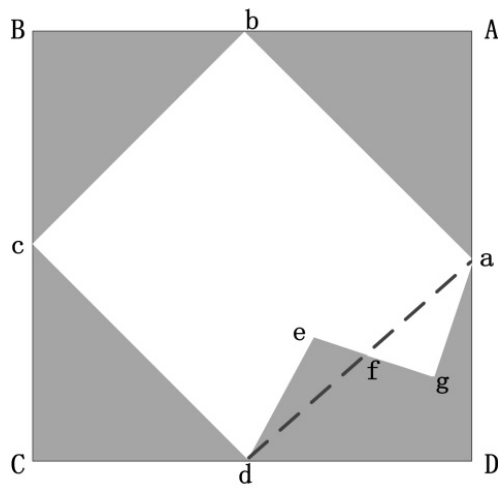
Figure 16. Demonstration of two categories. Table 1. Demonstration of the confusion matrix.